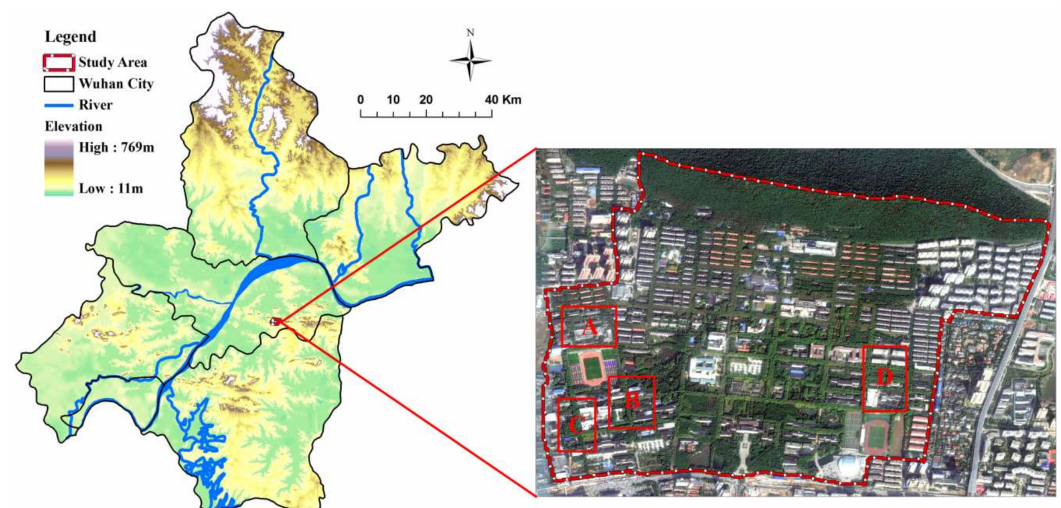
Figure 2. Study area: The main campus of Huazhong University of Science and Technology (HUST) in Wuhan City, China. The four regions that were reported to be most at risk from surface water flooding were: A—Nanyi Road; B—Zisong Road; C—Laboratory of Coal Combustion; and D—Doctor Apartment.